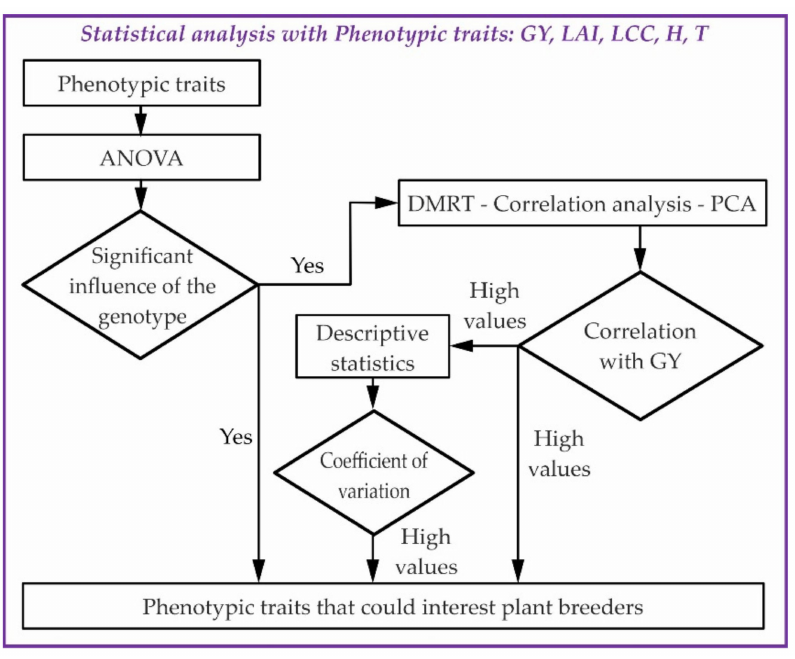
Figure 4. Workflow diagram of the statistical analysis for phenotypic variation and relationship with yield.